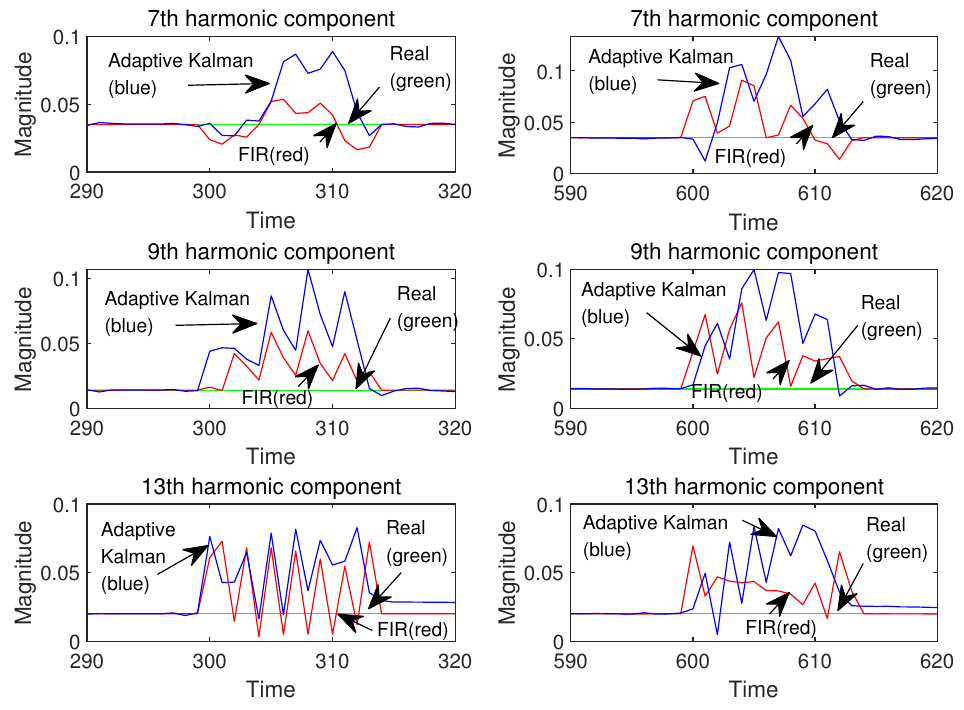
Figure 9. Real and estimated magnitude of 7th, 9th and 13th harmonic components. As seen in the result, the computation time of the proposed method is 72.84% less than that of adaptive Kalman filter-based